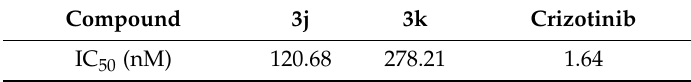
Table 4. Inhibitory effects of selected compounds on ALK activity.